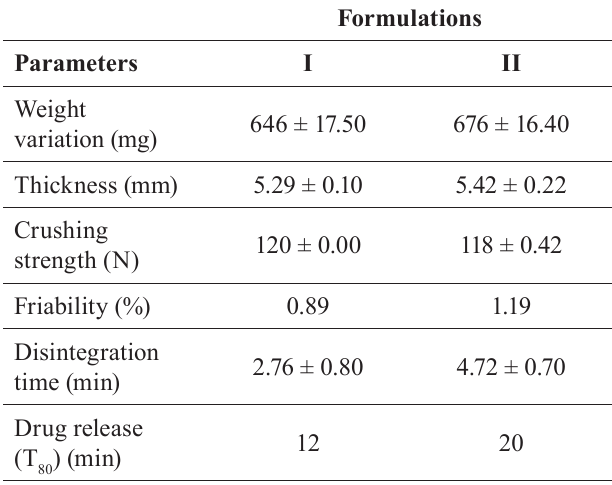
TABLE IX - Tablet parameters for the optimised and reference